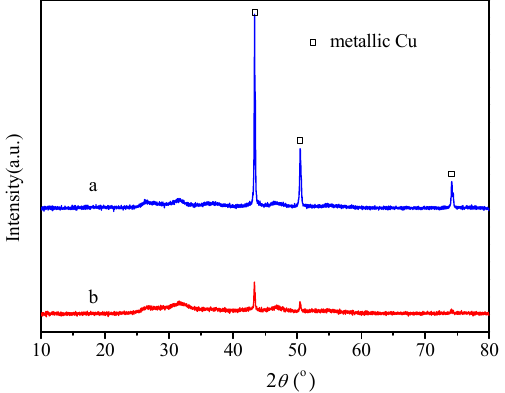
Figure 8. XRD patterns of used Cu 2 O samples after 24 h reaction. ( a ) Cu 2 O-NO 3 ; ( b ) Cu 2 O-Cl(2). Before characterization, the catalysts were washed with deionized water and then dried in a vacuum for 12 h at 30 °C.